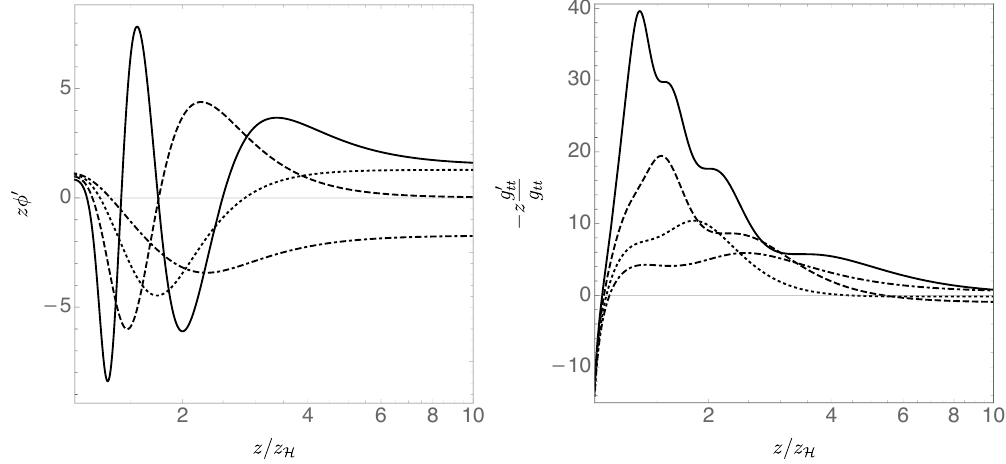
/ g as a function of z for temperatures tt tt